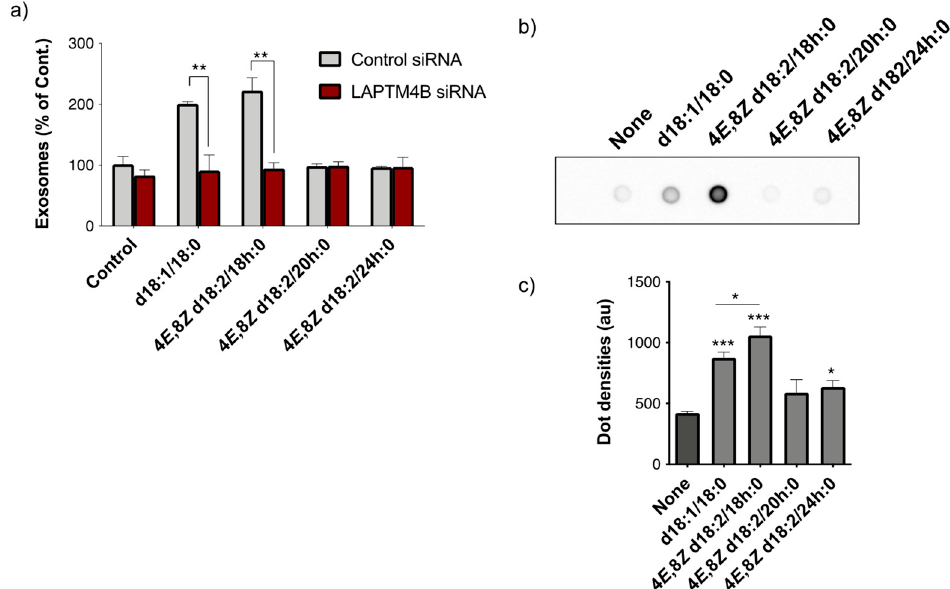
Figure 5. ( a ) The numbers of exosomes in the conditioned medium of SH-SY5Y cells treated with or without plant Cers following siRNA-induced knockdown of LAPTM4B. Data were normalized to the control and are represented as the mean ± S.D. ( n = 4). ** p < 0.01 (versus the Control siRNA). ( b ) A representative image of protein-ceramide overlay assay using GST-fused LAPTM4B and the indicated Cers. ( c ) The signal intensity of each dot was analyzed, and the data were represented as the mean ± S.D. ( n = 3; * p < 0.05, ** p < 0.01, *** p < 0.001, versus Control). au; arbitrary unit.